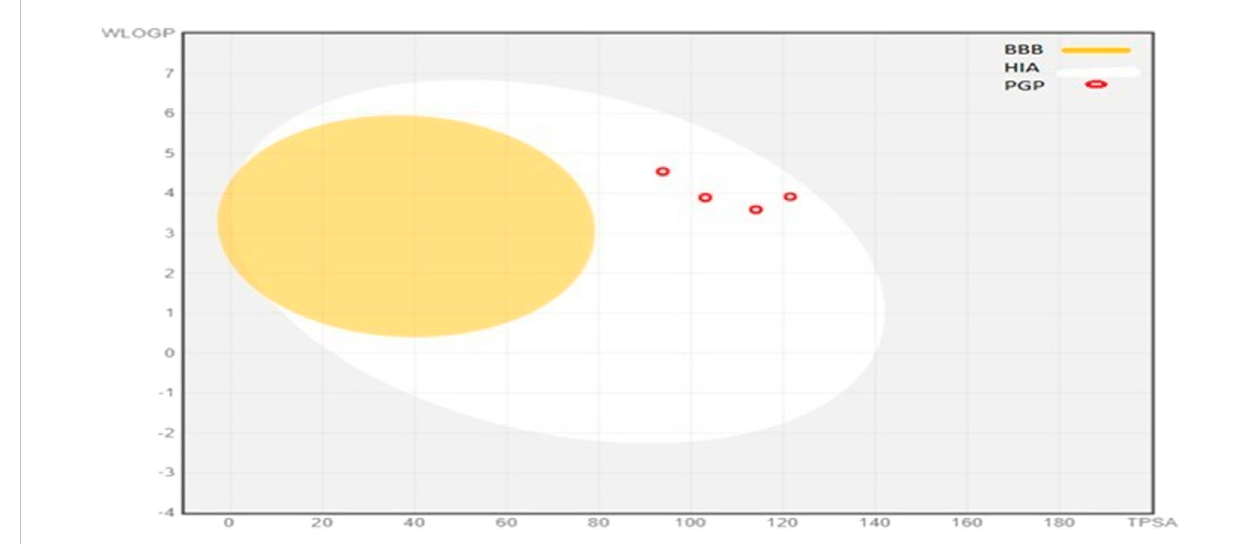
FIGURE 4 BOILED-Egg representations of absorption and distribution properties of (5a-5g) compounds. Egg white represen uman intestinal absorption (HIA), whereas egg yolk (yellow) shows blood-brain barrier permeability (BBB).